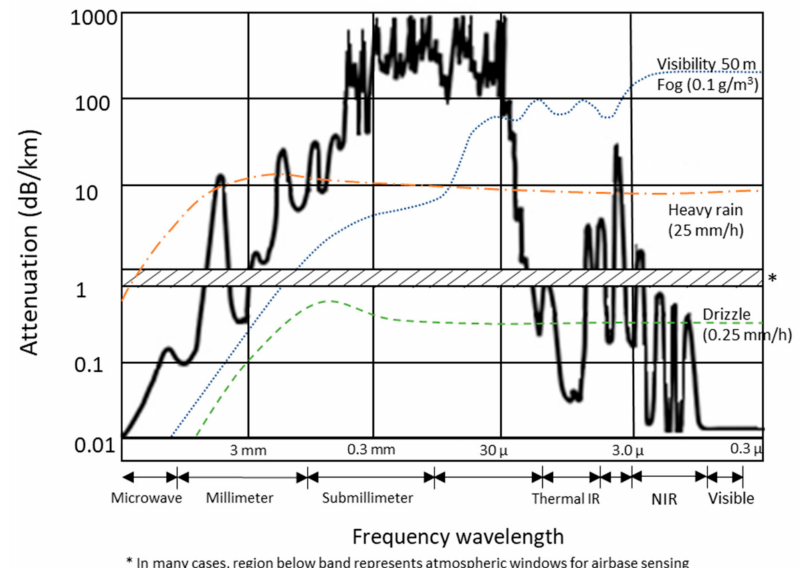
Figure 17. Attenuation due to fog, rain, and drizzle. From [54], reproduced with